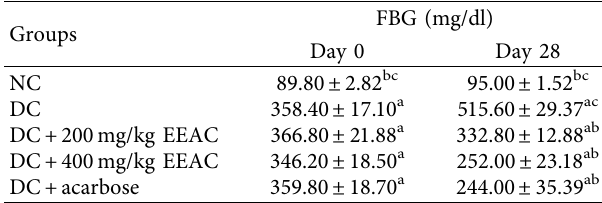
Table 3: Fasting blood glucose of experimental animals after 28 days oral administration of EEAC from antidiabetic activity